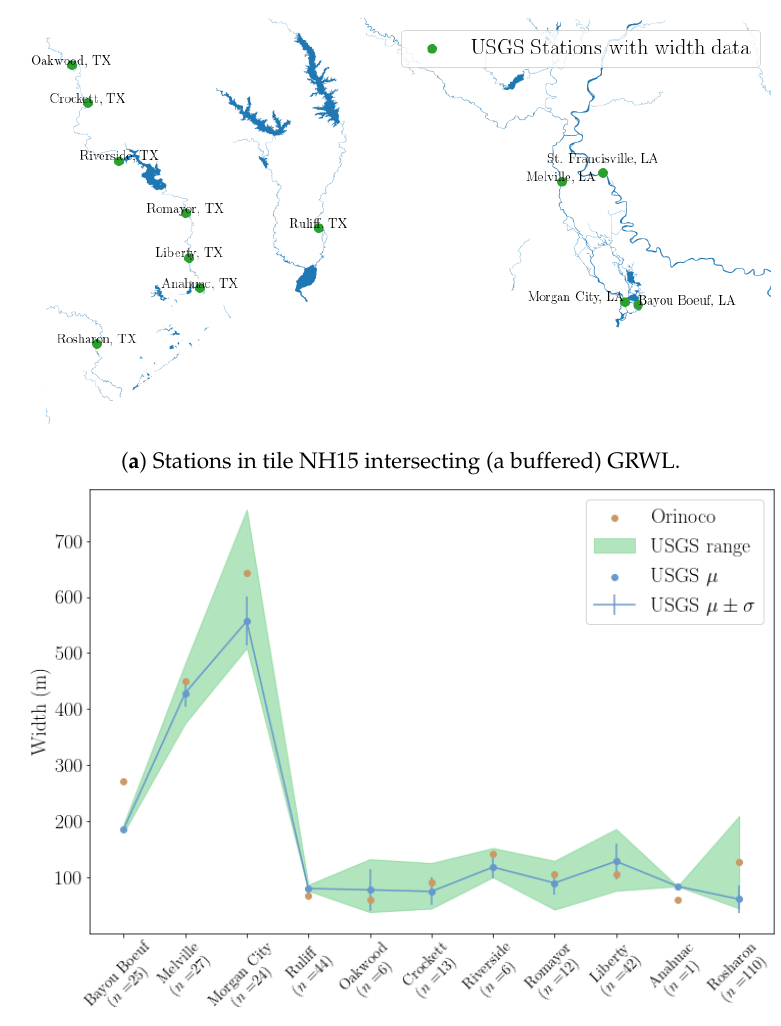
Figure 9. In the top panel ( a ), we show those USGS stations intersecting the GRWL water mask or those stations within 60 m. In the bottom panel ( b ), we compare the closest Orinoco width with the range of USGS widths as well as the the mean width µ and the range of widths within 1 standard deviation µ ± σ . The value n below the USGS station name indicates how many measurements were